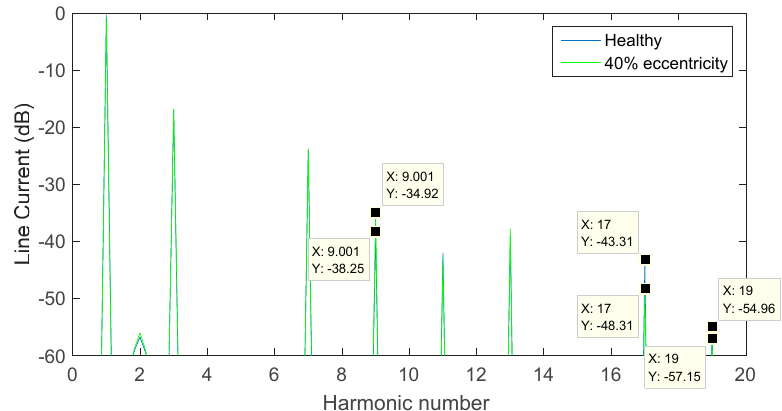
Figure 5. Rated operating conditions. Spectral content of the line currents. Healthy machine and faulty machine with 40% eccentricity.